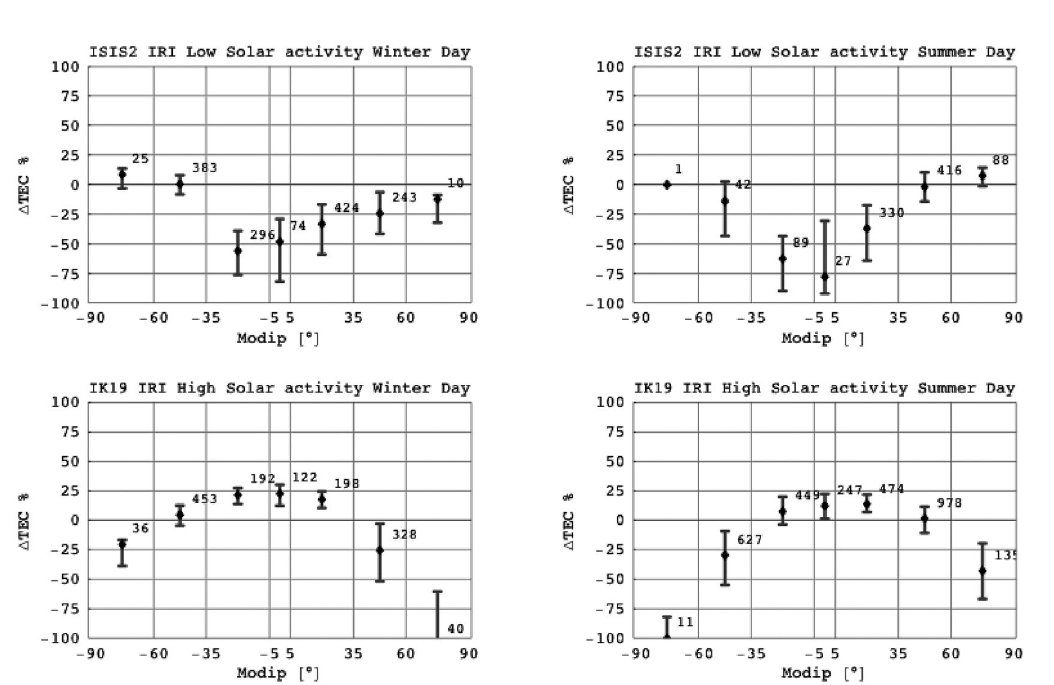
Fig. 18.14. Percent difference between experimental topside TEC and IRI topside TEC. Numbers indicate the amount of data in each